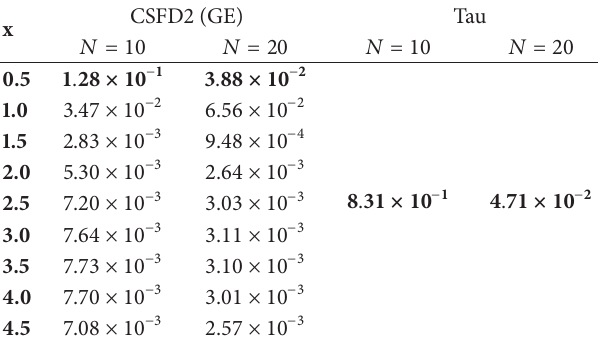
Table 3: Comparison between CSFD2 (GE) and Tau method for Example